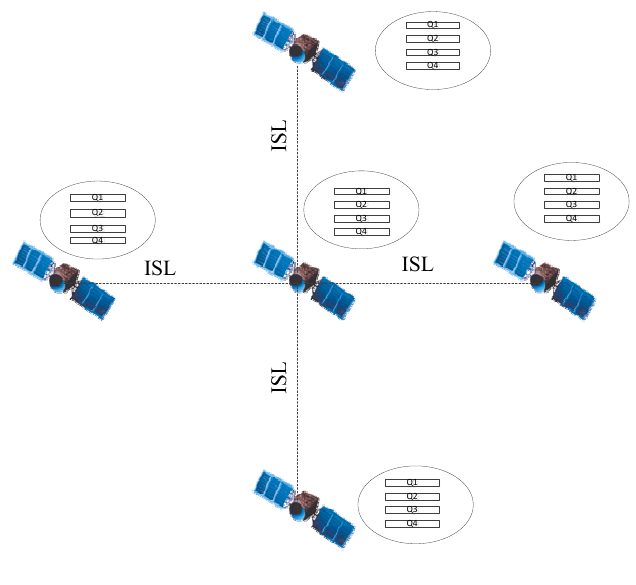
Figure 3. Queue model.